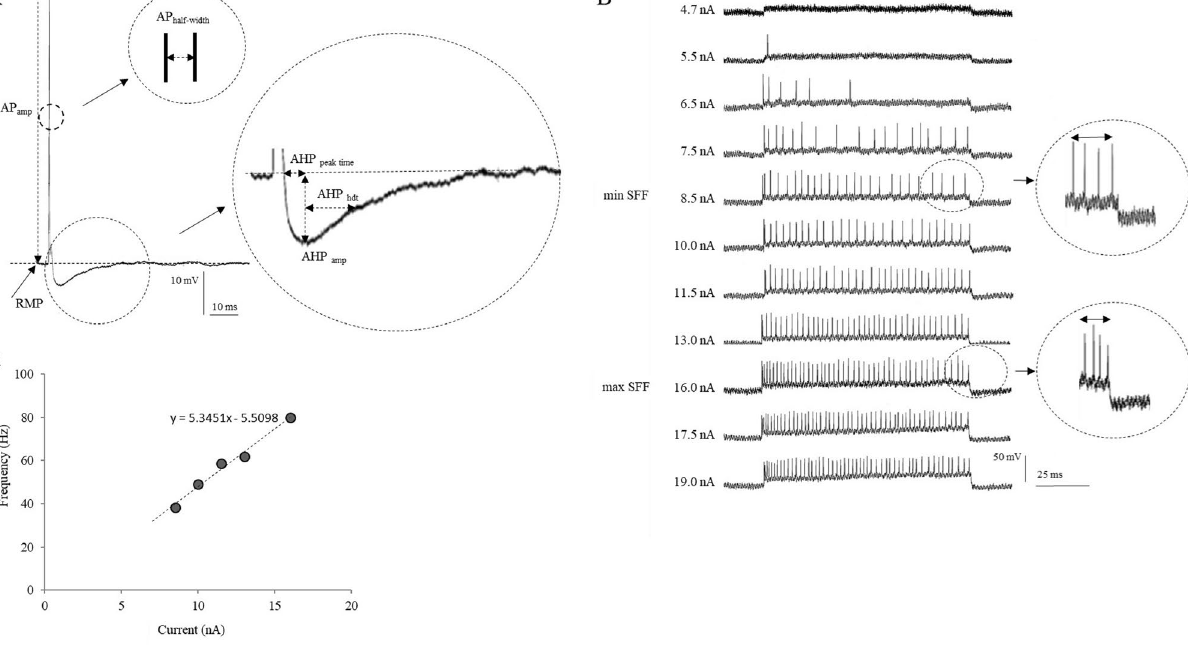
Figure 5. Examples of recordings obtained from a tibialis anterior MN from a Bdnf + / + rat. ( A ) Action potential parameters: RMP: resting membrane potential; AP amp : action potential amplitude; AP half-width : action potential duration measured at the level of half-amplitude; AHP peak time : time to afterhyperpolarization (AHP) peak; AHP amp : AHP amplitude; AHP hdt : AHP half-decay time. ( B ) Discharge patterns generated by a MN during a gradually increasing injection of intracellular current. Note the lack of rhythmic firing until intracellular stimulation at 8.5 nA (minimum steady-state firing [SSF] frequency: 38.2 Hz) and the maximum SSF frequency at 16 nA (80.0 Hz) without further increases at stronger intracellular stimulation levels. SSF frequencies were calculated from the last three inter-spike intervals (indicated with circles). ( C ) The frequency- current relationship (f/I) for the rhythmic firing in this MN, assessed based on the equation y = ax + b, where “a” determines the slope of the